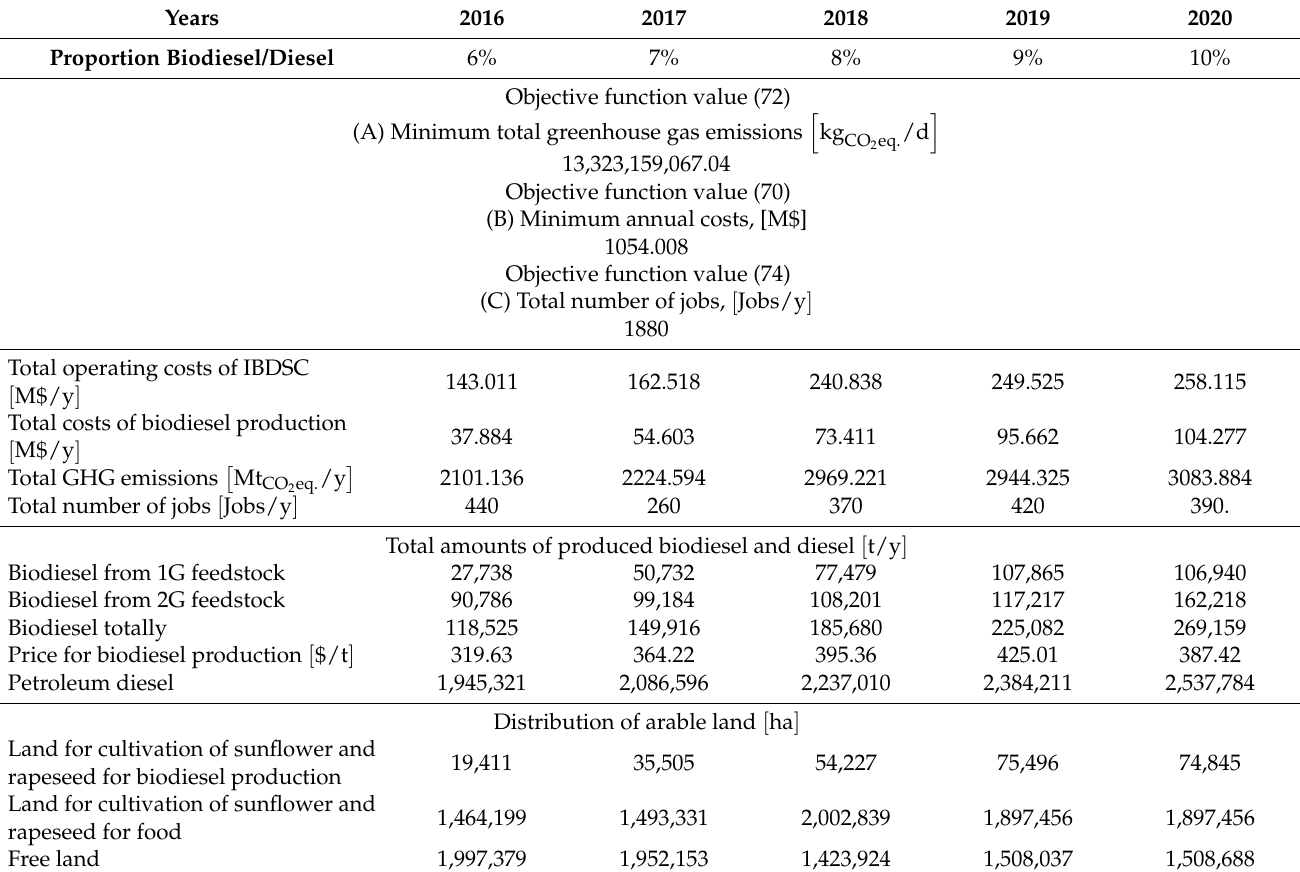
Table 12. Results obtained from the optimization problem solution using criterion: (B) Minimum total annual